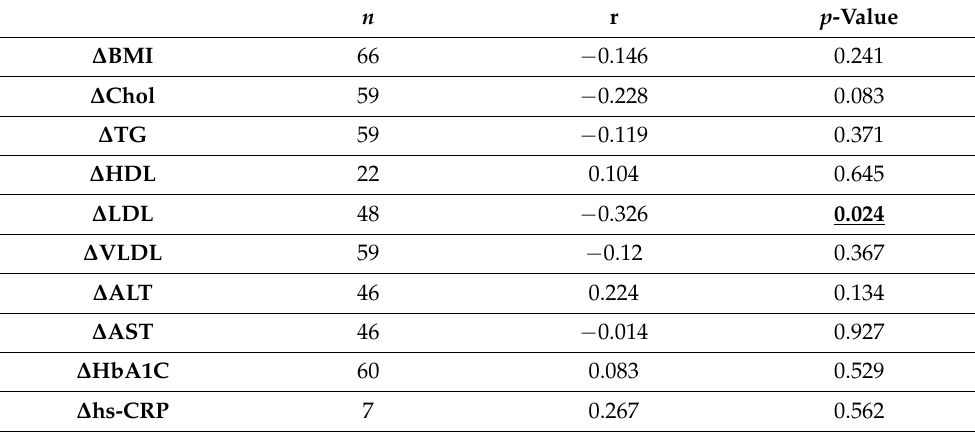
Table 6. Correlation between GLP-1 agonist dose and change in clinical